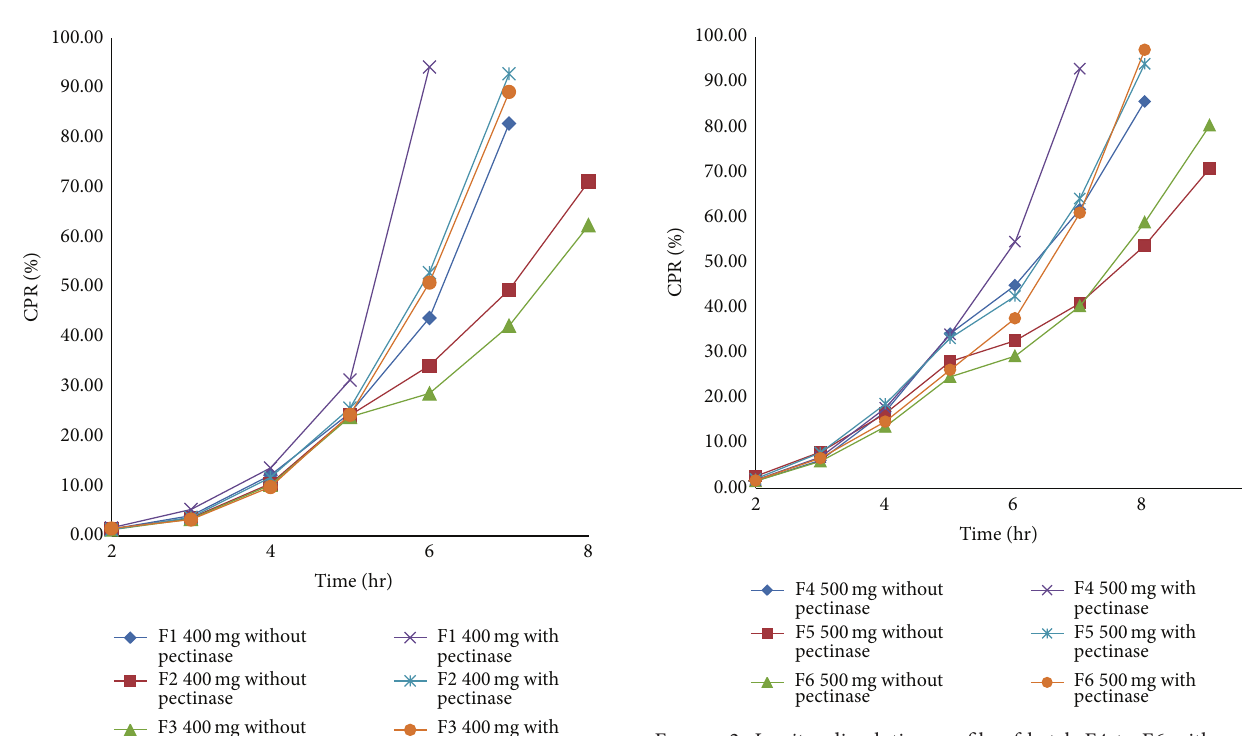
Figure 2: In vitro dissolution profile of batch F4 to F6 with and without pectinase enzyme.